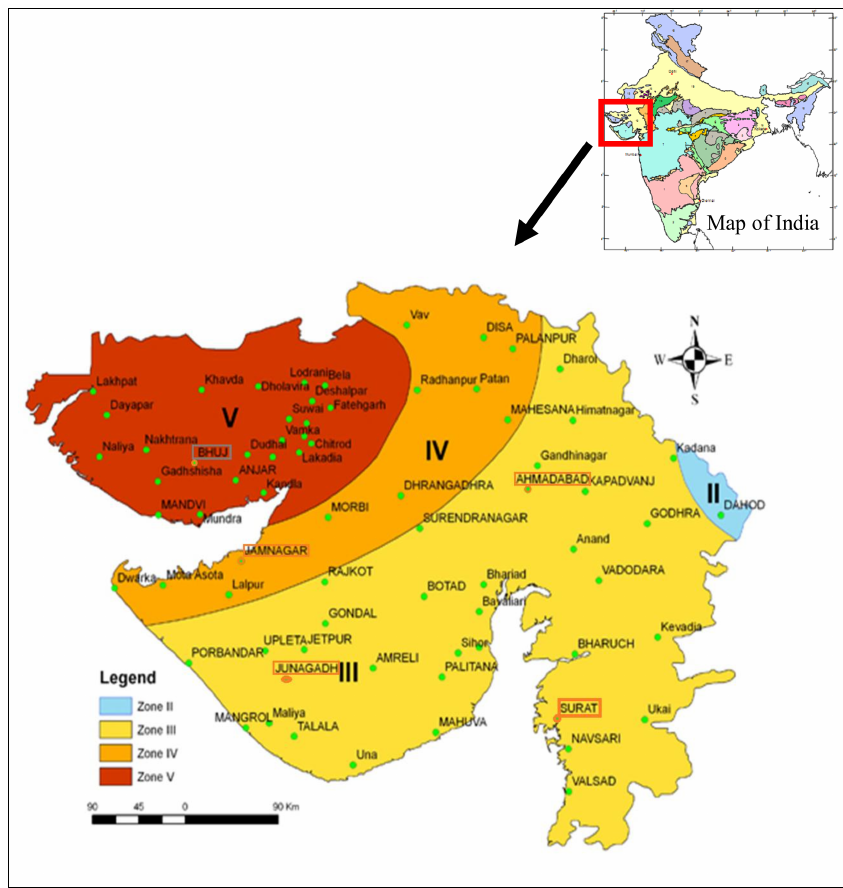
Fig. 1. Geographical location of the Gujarat region in India (highlighed in inset) and seismic zonation map for the Gujarat region (cities under consideration in present study highlighted by red enclosed region). (Ref figure from ISR web site-www.isr.gujarat.gov.in, last accessed on 10 October